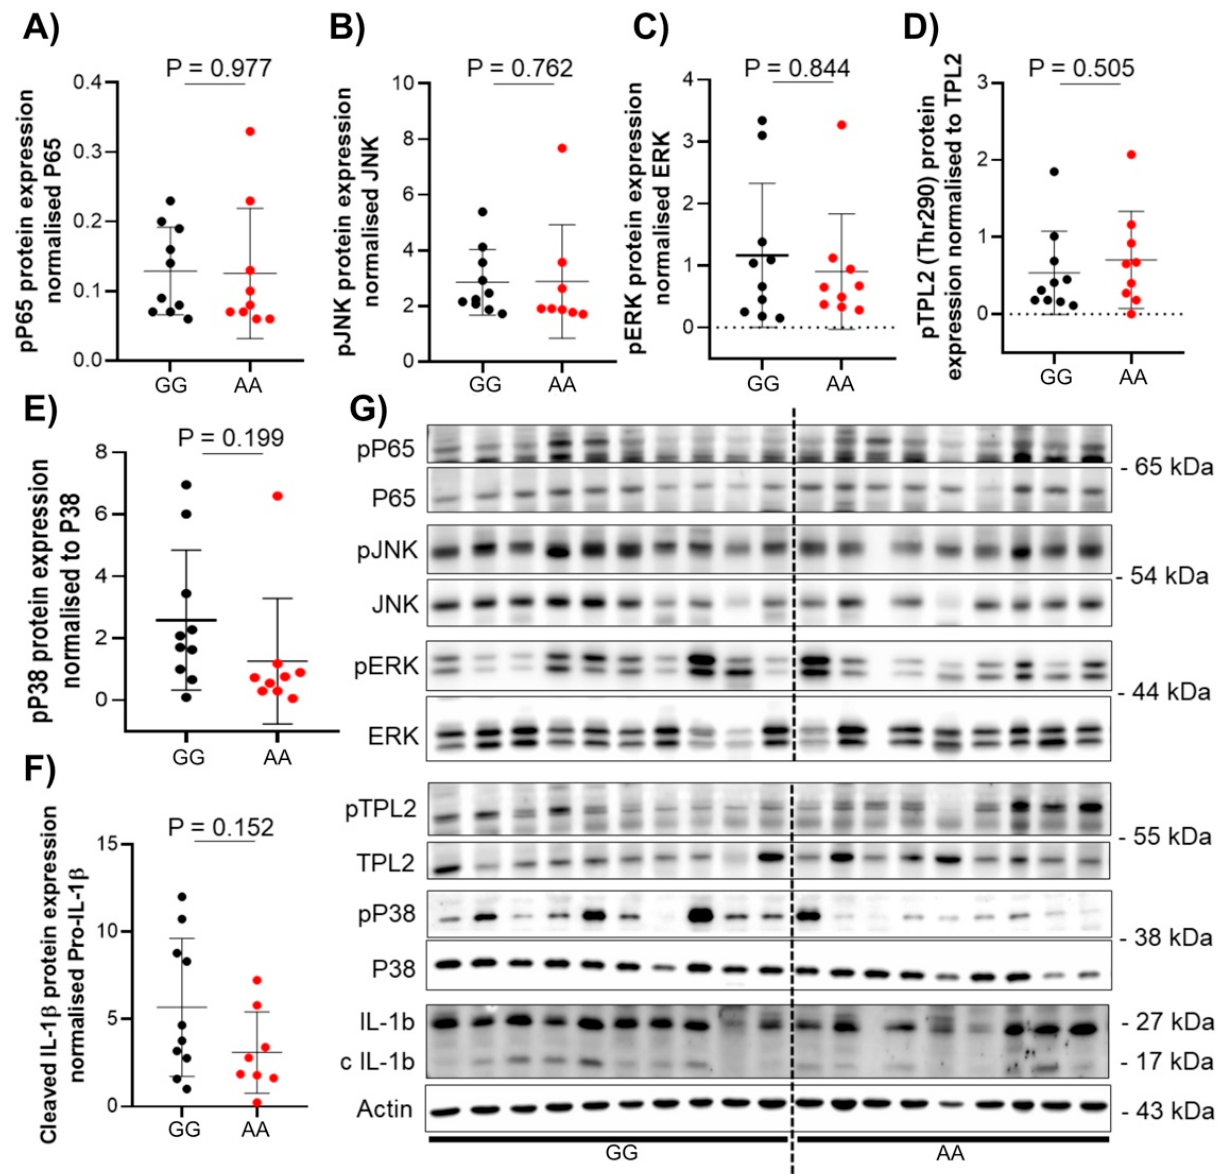
Figure 2. Protein expression of TPL2 downstream pathway in CD patient with or without rs1042058 TPL2 variant. Analysis of protein expression in human colon biopsies was performed using western blot from CD patients with or without rs1042058 TPL2 variant. ( A – F ) Dots in the graph represent individual patients. Red circles represent patients with the rs1042058 TPL2 variant, and black circles represent patients without the rs1042058 TPL2 variant. ( G ) Each lane in the Western blot image represents individual patients. Error bars represent means ± SD.